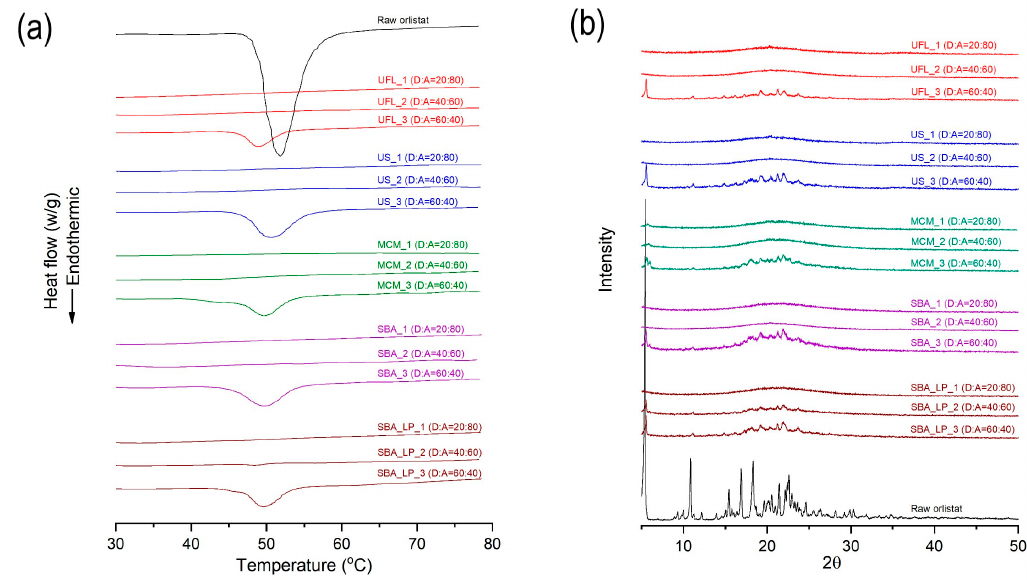
Figure 4. DSC thermograms ( a ) and PXRD patterns ( b ) of raw orlistat and orlistat-loaded mesoporous silica at 20%, 40%, and 60% drug loading ratio. D:A is the mass ratio of drug to